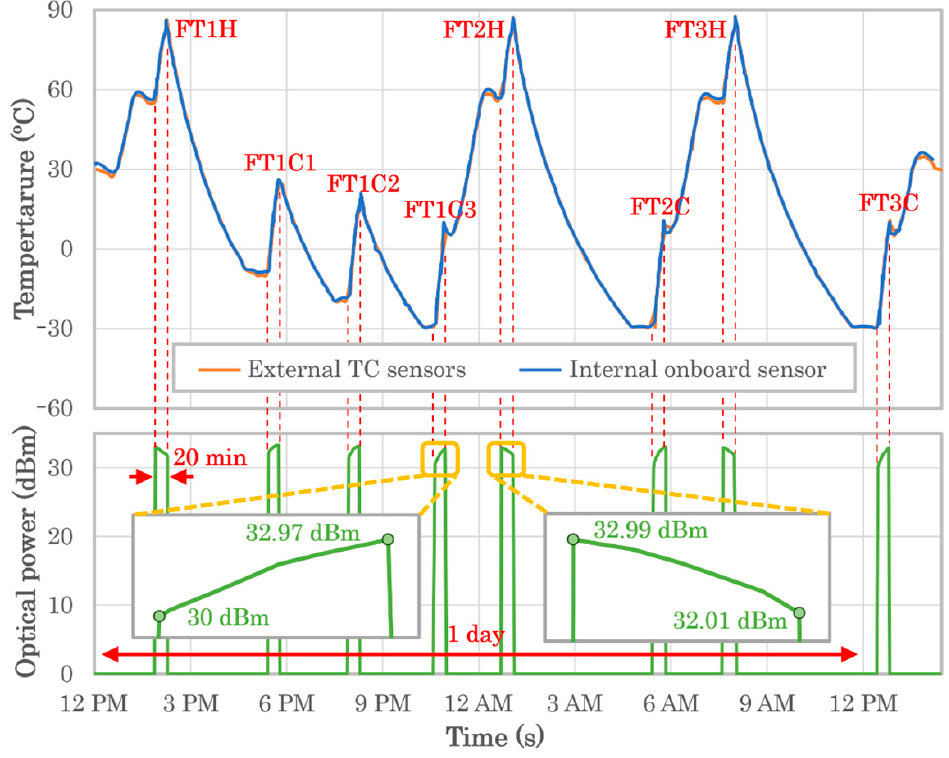
Figure 12. EDFA’s module full functional verification during 24 h thermal vacuum test with cold and hot cycles.